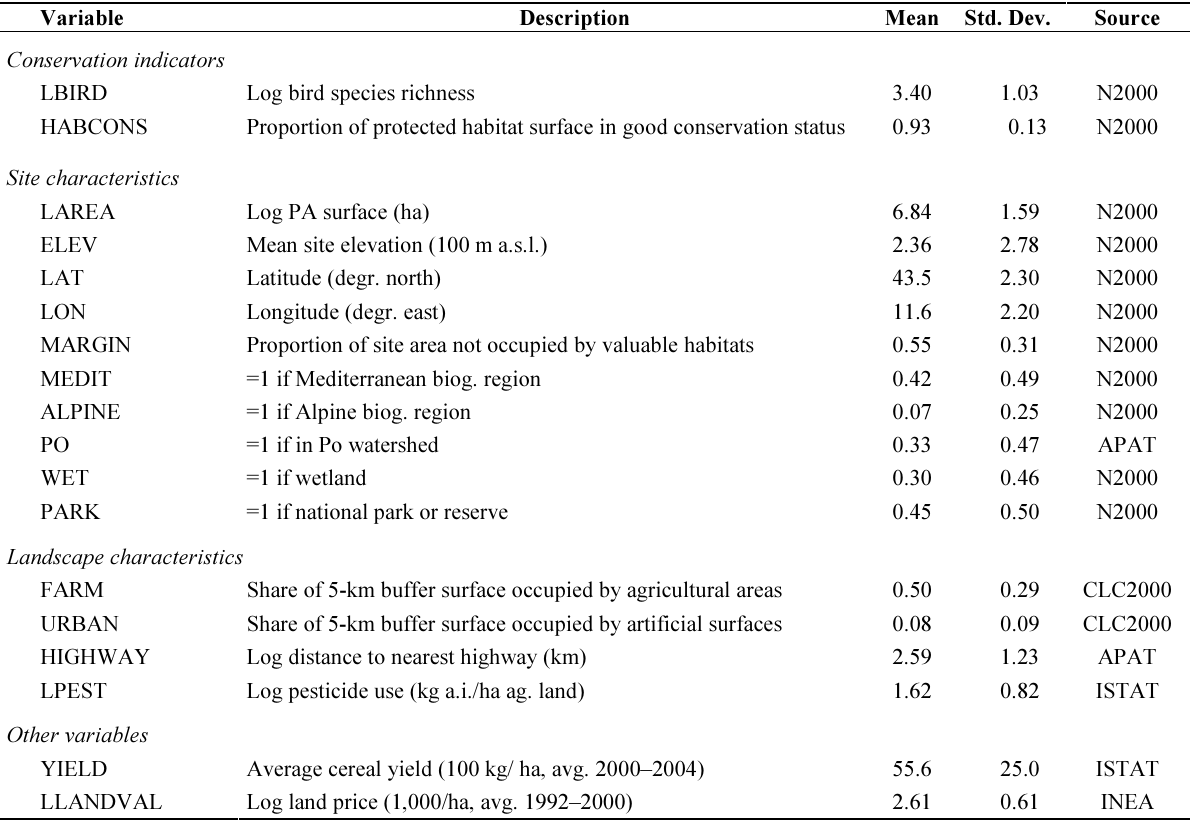
Table 1. Descriptive statistics (N. Obs = 300; only 289 obs. on HABCONS)